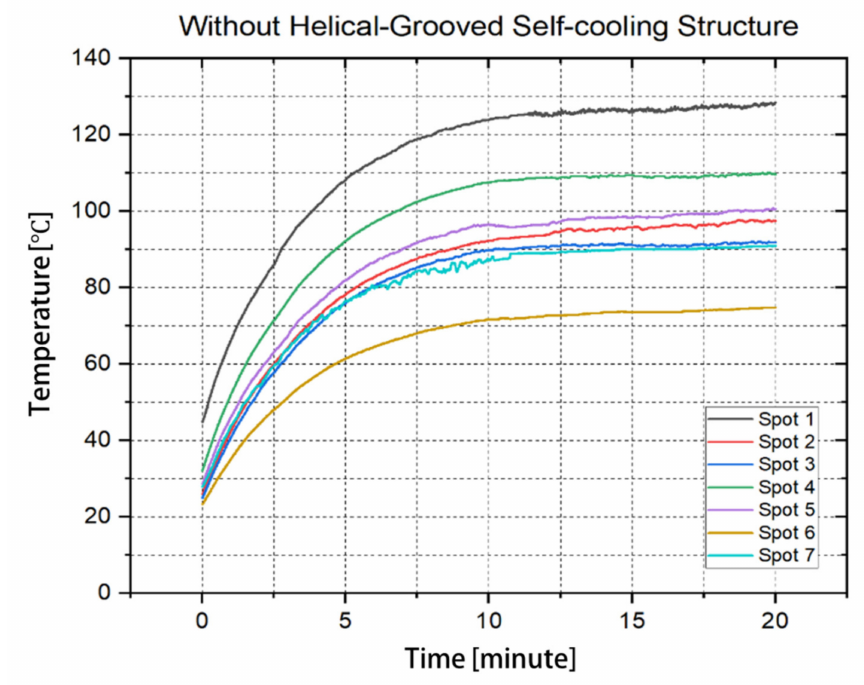
Figure 10. Heat dissipation experimental results of motor A.